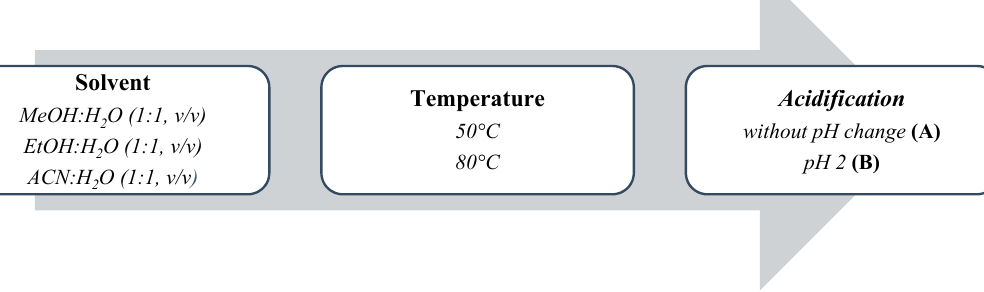
Figure 1. Selection of the optimal Accelerated Solvent Extraction (ASE)-SPE conditions for the isolation of target compounds from plant materials.